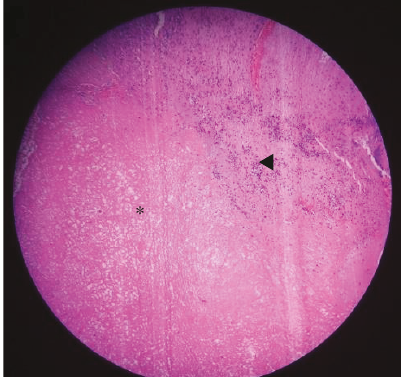
Figure 5: This is a section taken from the main thrombus showing heavy deposition of eosinophilic fi brin material ( ∗ ) with entrapped erythrocytes and in fl ammatory cells ( ◀ ).